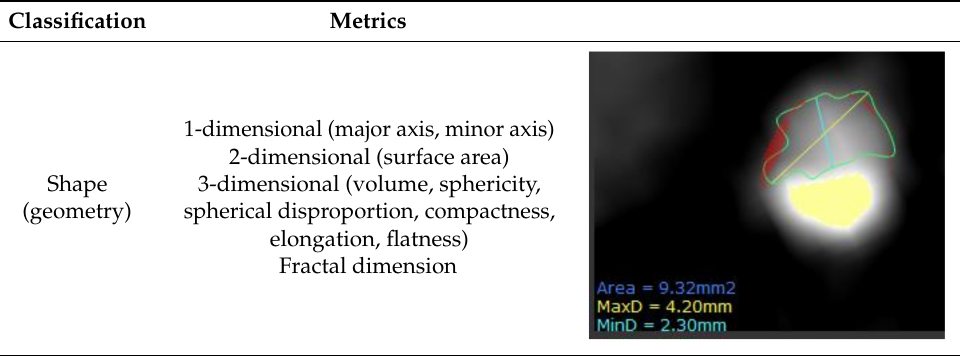
Table 1. Classification of different radiomic